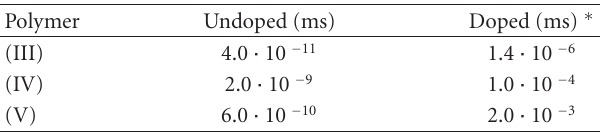
Table 1: Conductivity of doped and undoped polymers (III), (IV),